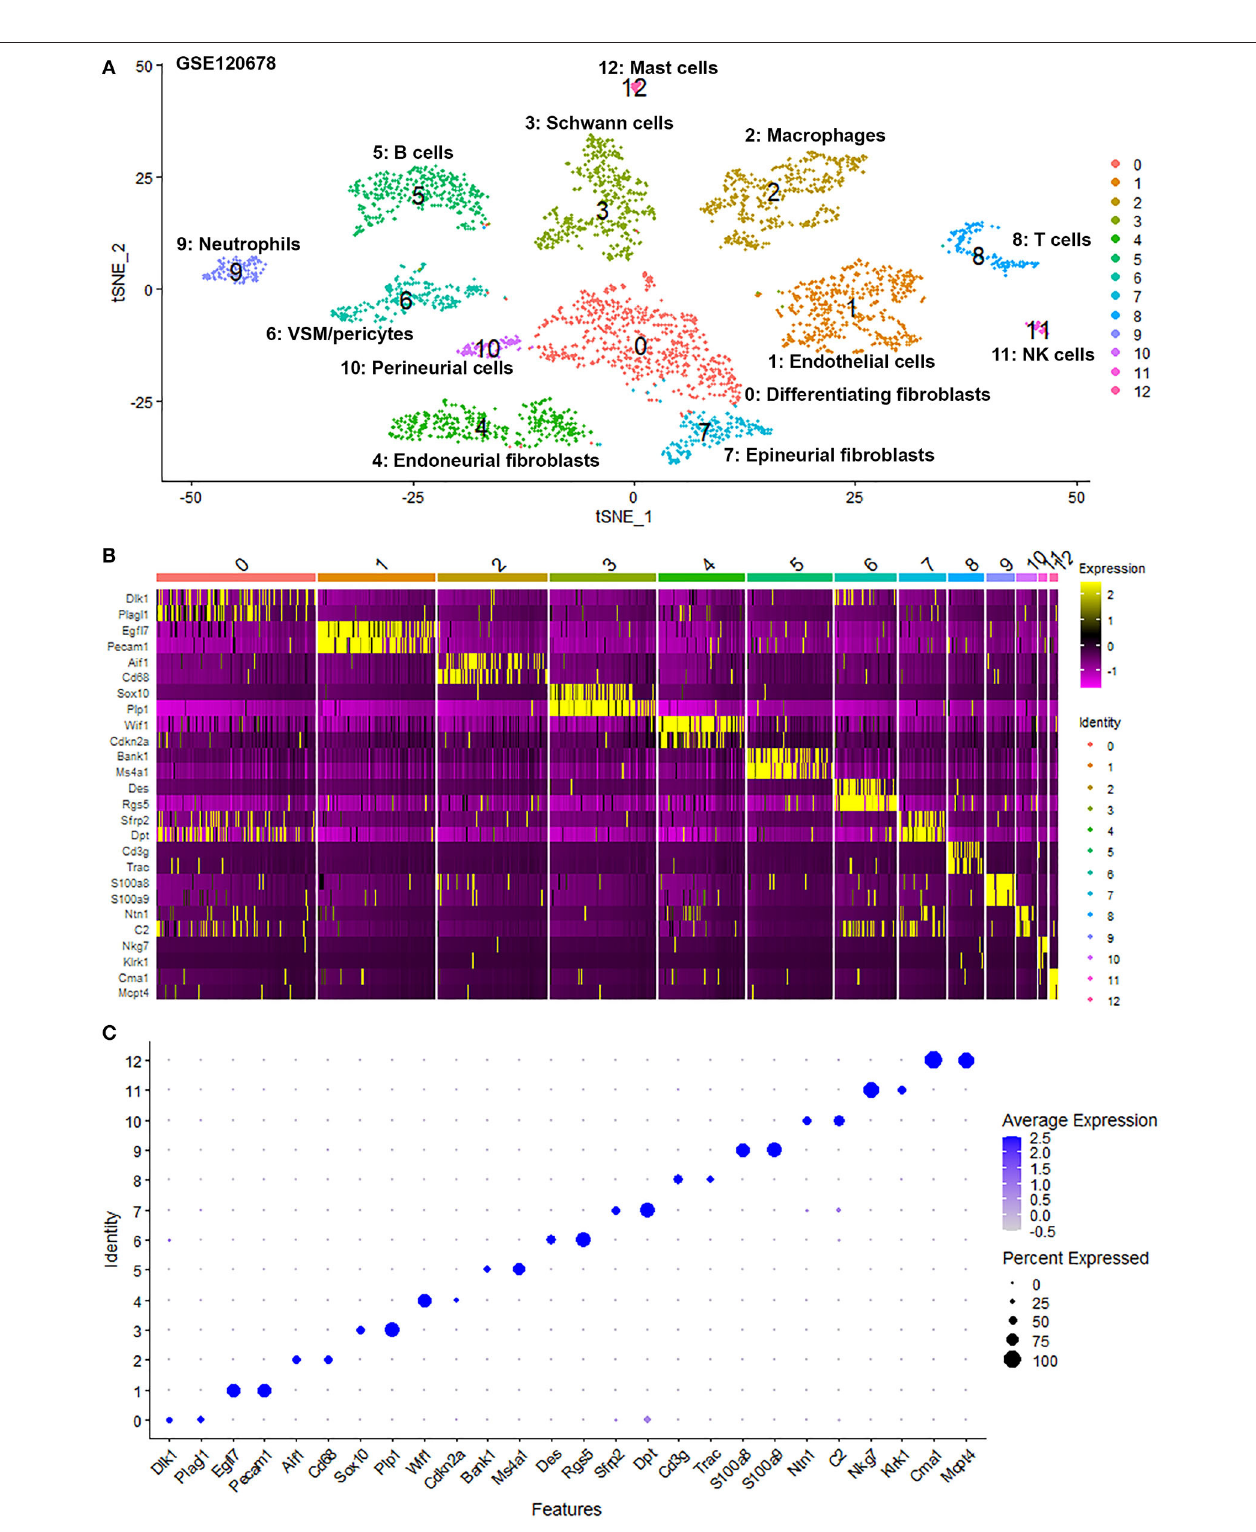
FIGURE 3 | Single cell transcriptomics (GSE120678) defines cellular phenotypes in day 9 post-injury distal mouse sciatic nerve. (A) tSNE visualization of cell clusters in day 9 post-injury distal mouse sciatic nerve. 0: Differentiating fibroblasts; 1: Endothelial cells; 2: Macrophages; 3: Schwann cells; 4: Endoneurial fibroblasts; 5: B cells; 6: VSM/pericytes; 7: Epineurial fibroblasts; 8: T cells; 9: Neutrophils; 10: Perineurial cells; 11: NK cells; 12: Mast cells. (B) Heat map of selected marker genes for each cell cluster. (C) Dot plot of selected marker genes for each cell cluster.